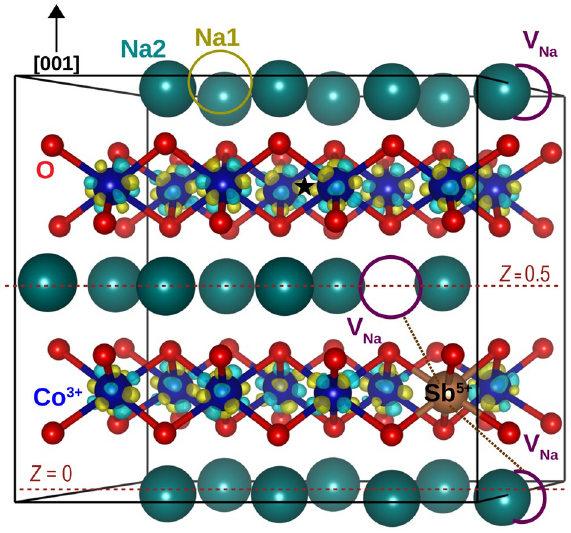
Fig. 1 The spin density of the 2 a × 4 a × 1 c supercell used for simu- lating Sb-doped Na 0.875 CoO 2 compound in the most stable con- figuration. Co and O ions occupy the Wyckoff 2 a and 4 f sites of the hexagonal lattice structure, respectively. In Na 0.875 CoO 2 , all Na ions occupy 2 c (Na2) sites. For smaller Na concentrations, some Na ions occupy 2 b (Na1) sites. The distance between V Na and Sb 5+ is marked with dotted brown lines. The spin density isosurfaces were drawn at ρ = 0.035 e/Å 3 . Yellow and cyan surfaces indicate spin-up and spin- down,